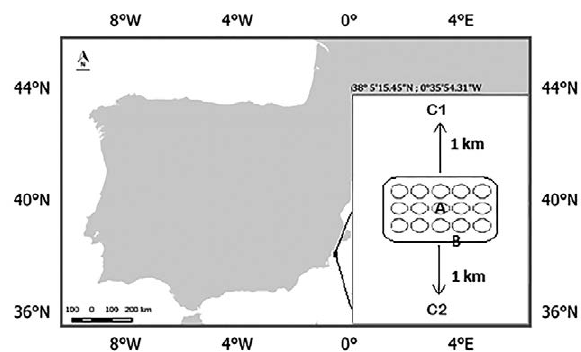
Fig. 1. – Location map of Guardamar bay and the fish farm, south- east Spain.